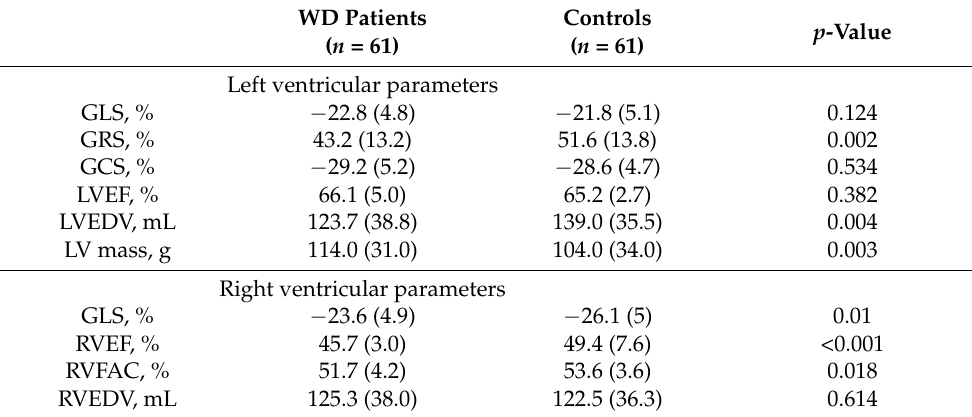
Table 3. Myocardial strain and CMR characteristics of patients and controls.